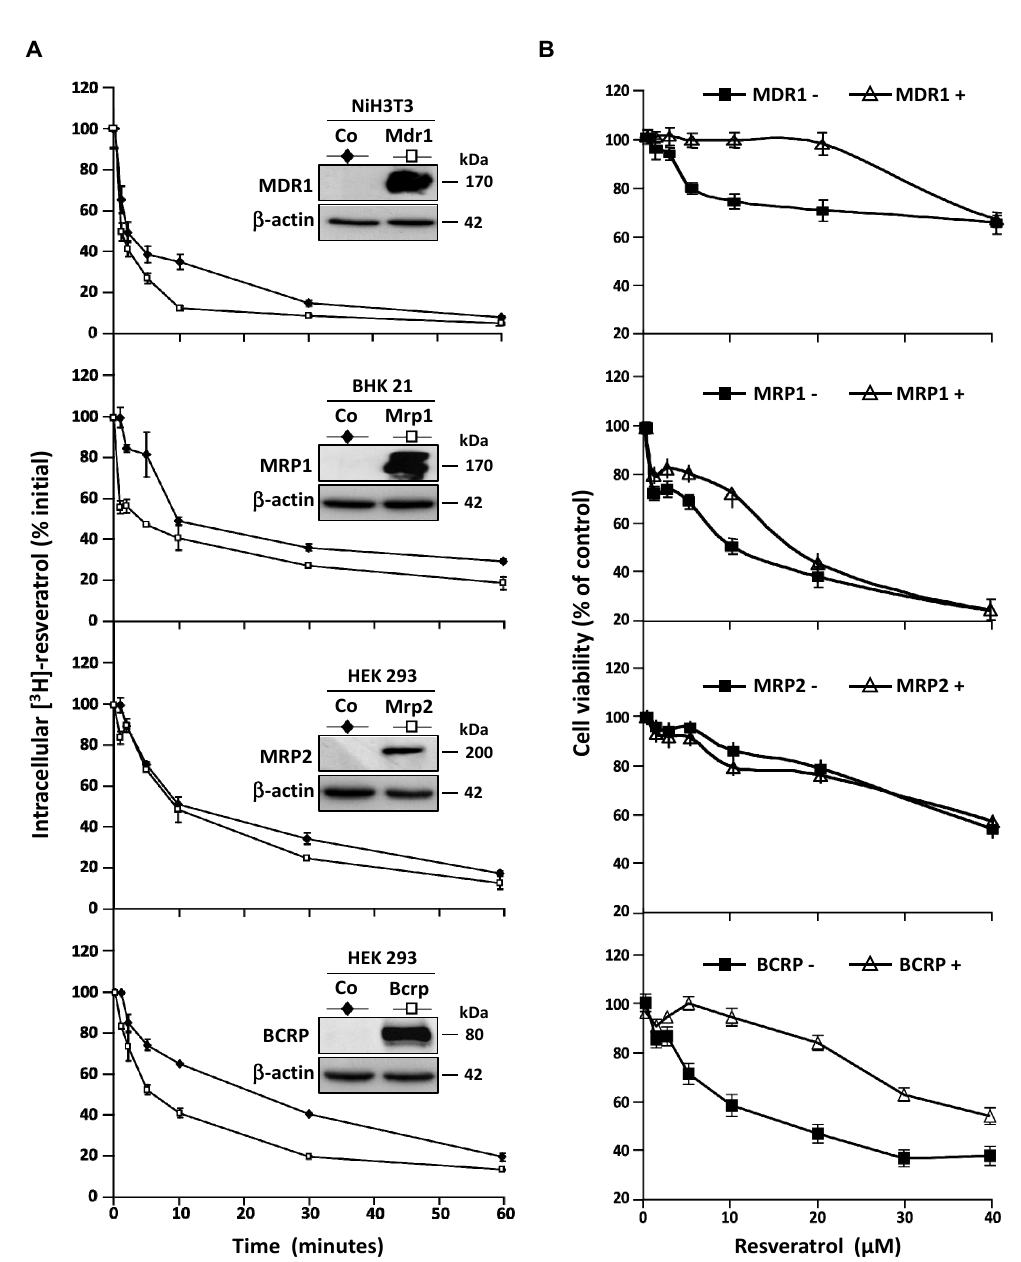
Figure 4. Resistance of colon cancer cell lines to resveratrol involves ABC transporters. ( A ) Control NiH3T3, BHK 21, HEK 293, and respective overexpressing clones NiH3T3/MDR1, BHK 21/MRP1, HEK 293/MRP2, and HEK 293/BCRP were submitted to time course measurement of [ 3 H] resveratrol efflux. Cells were grown in 6-well plates until confluence and treated for 10 min with 30 µM of [ 3 H] resveratrol (uptake phase). Cells were then quickly washed with PBS and [ 3 H] resveratrol was allowed to efflux in fresh medium at 37°C for indicated times. Cells were lyzed and radioactivity levels were determined and plotted as percentages of initial levels measured after uptake phase. Inserts are western blot evaluation of ABC transporters proteins levels in control cells against stably transfected ones. Data are means ± SD ( n = 3) of a representative experiment among three independent ones. Results are statistically different between control and ABC transporters overexpressing cells with p -value at least < 0.05 by Student’s test. ( B ) Dose–response curves to resveratrol in control and stably transfected cells after 72 h of treatment. Cell viability was expressed as percentage of control (vehicle alone). Data are mean percentage ± SD of three independent experiments each containing six replicates per condition.